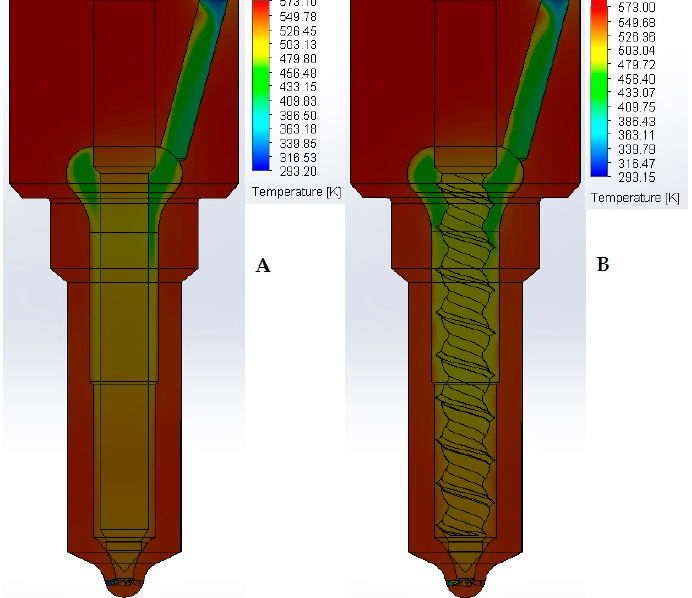
Figure 10. The results of preliminary simulation studies of temperature distribution of body and needle at the pressure of 135 MPa. ( A ) Standard atomizer; ( B ) modified atomizer.